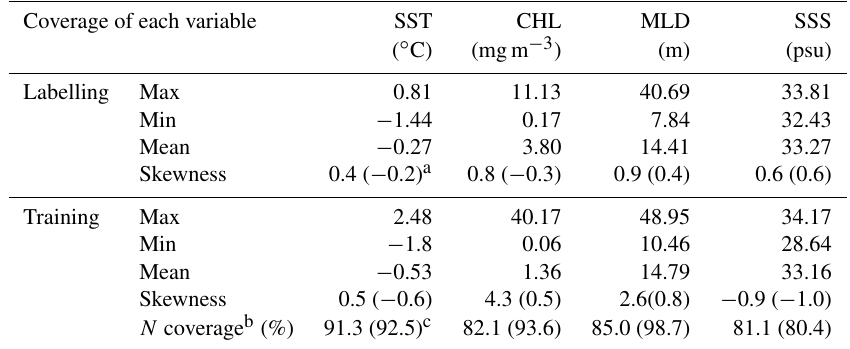
a The skewness of the common logarithm of each variable is shown in parentheses. b Number of training data within the labelling data range/total number of training data. c The percent labelling data coverage of normalized variables is shown in parentheses.